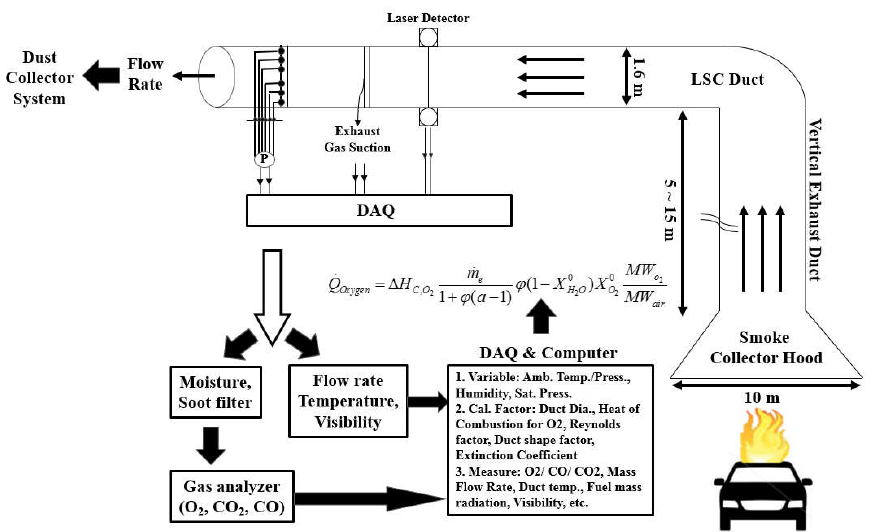
Figure 1. Schematic diagram of the basic concept for this study.